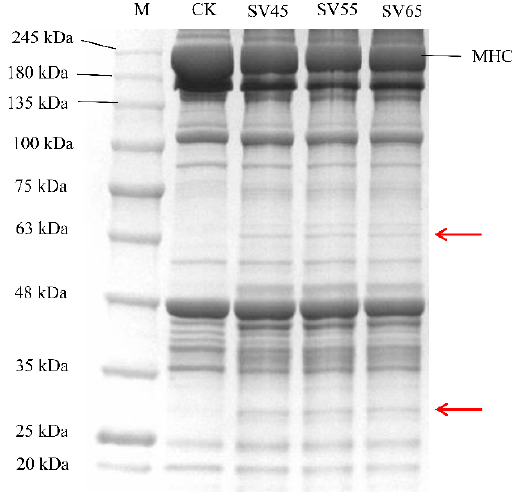
Figure 5. SDS-PAGE of myofibrillar proteins extracted from beef semitendinosus of CK and SV samples. M: molecular weight markers, MHC: myosin heavy chain.